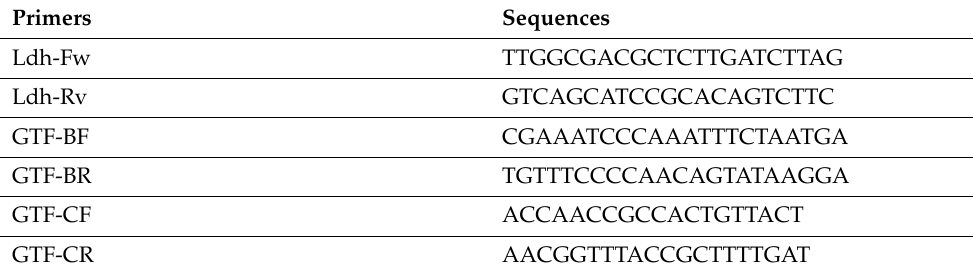
Table 1. Primers for